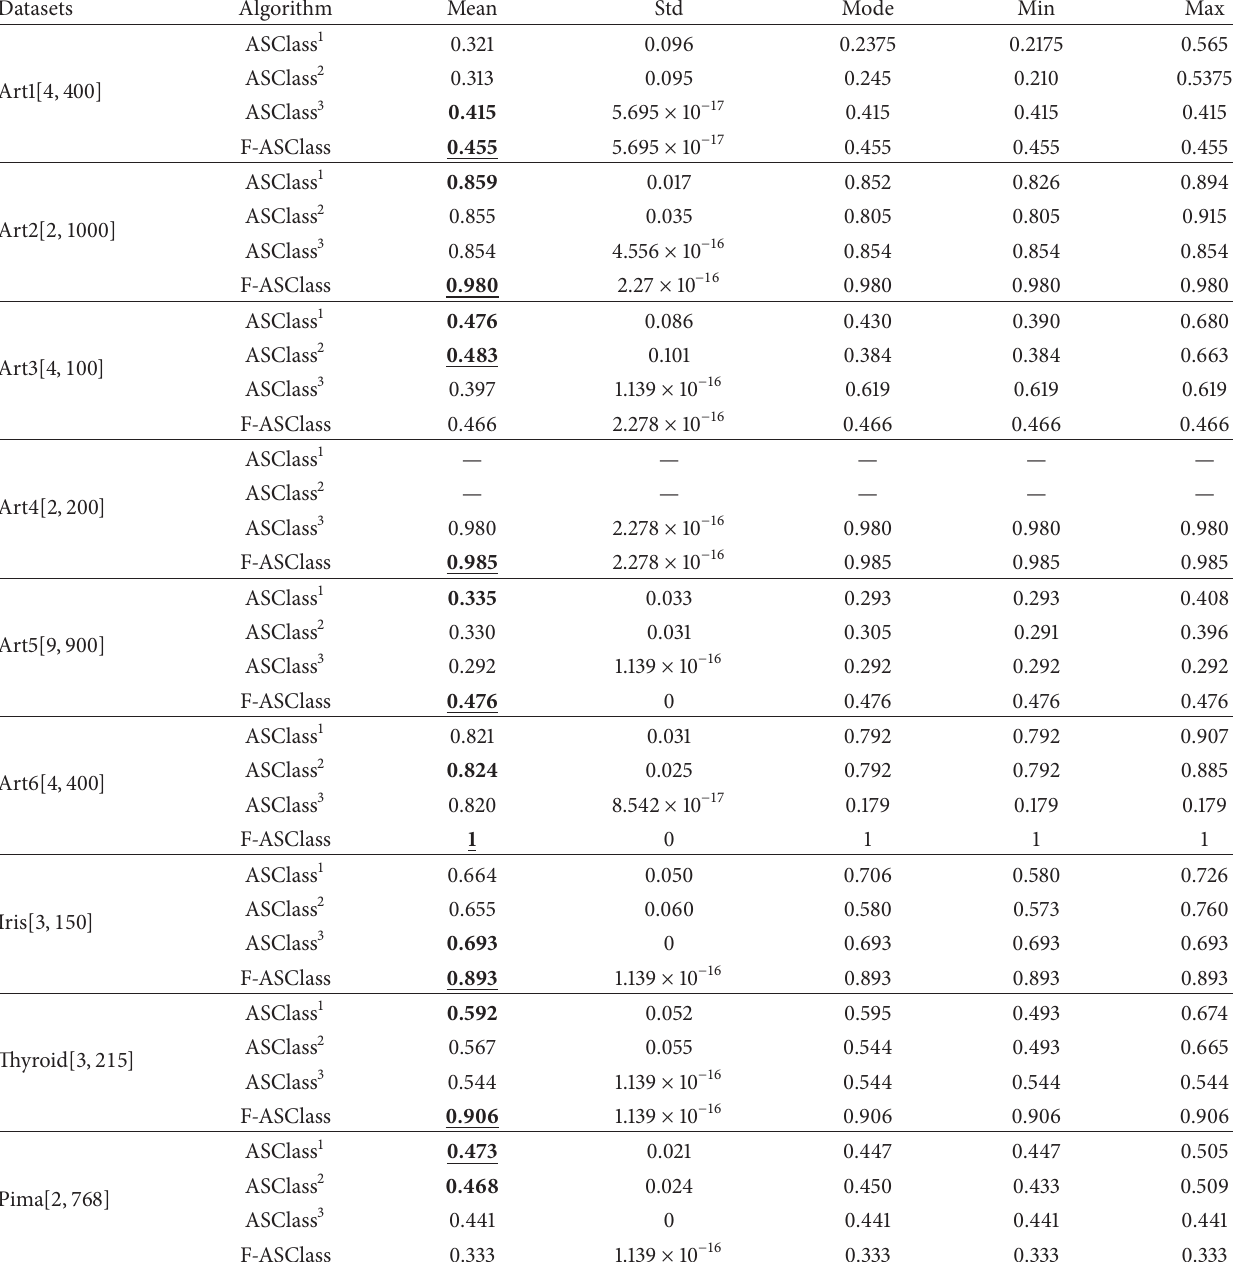
Table 7: Mean, standard deviation, mode, min, and max values of accuracy classification achieved by each clustering algorithm (ASClass 1 , ASClass 2 , ASClass 3 , and F-ASClass) over 20 trials on dataset presented in Table